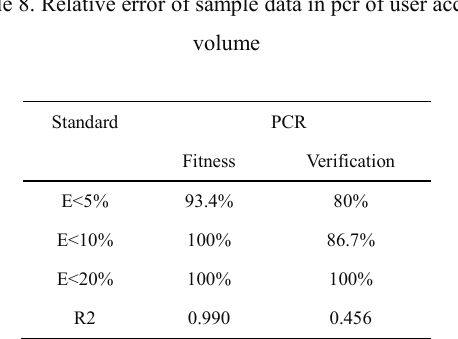
Table 9. Qualified rate and determination coefficient of pcr